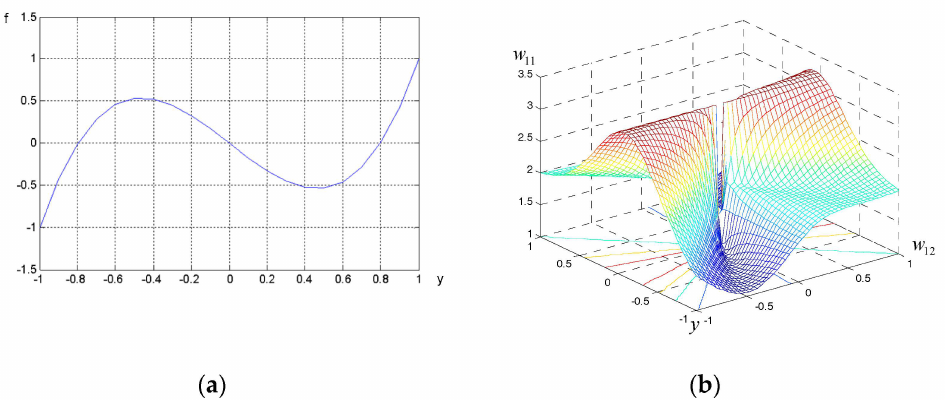
Figure 3. Activation function ( a ) and objective function surface ( b ).